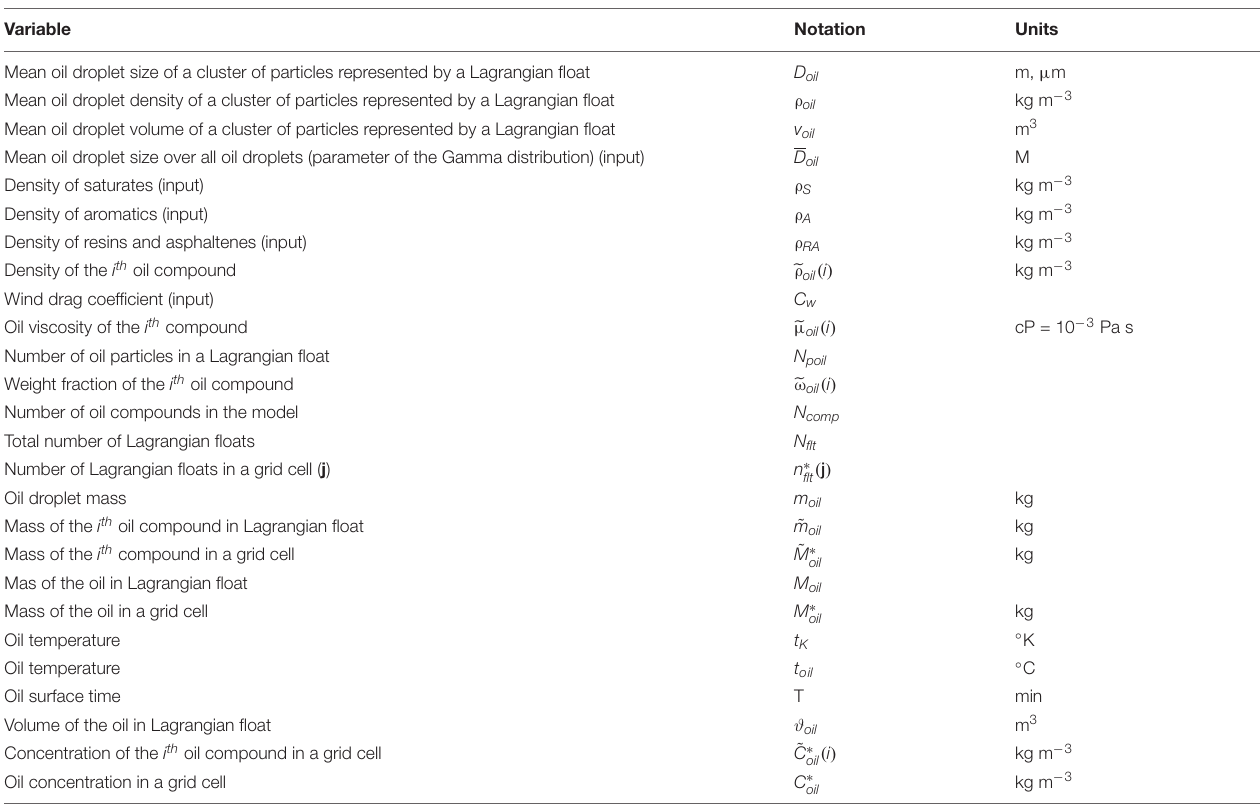
TABLE 2 | List of variables, their notations and units. Variable Notation